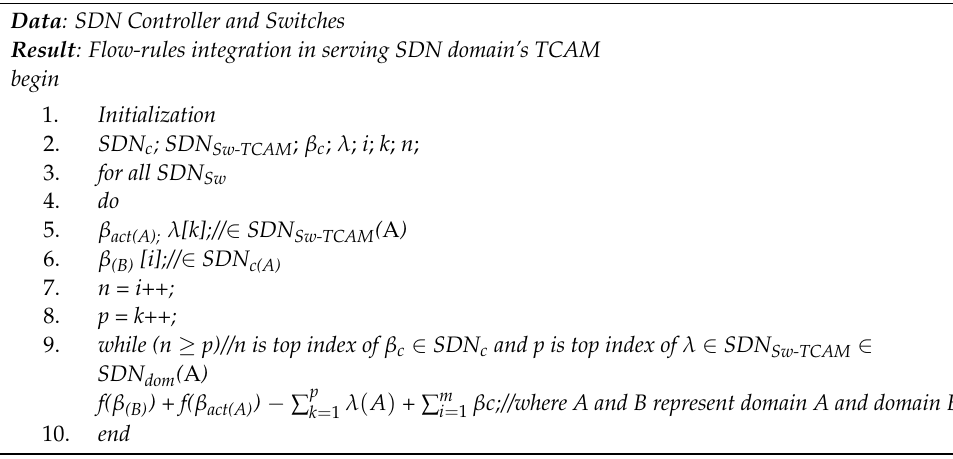
Algorithm 3: Flow-Rule Integration in TCAM for the New Mobile Node Data : SDN Controller and Switches